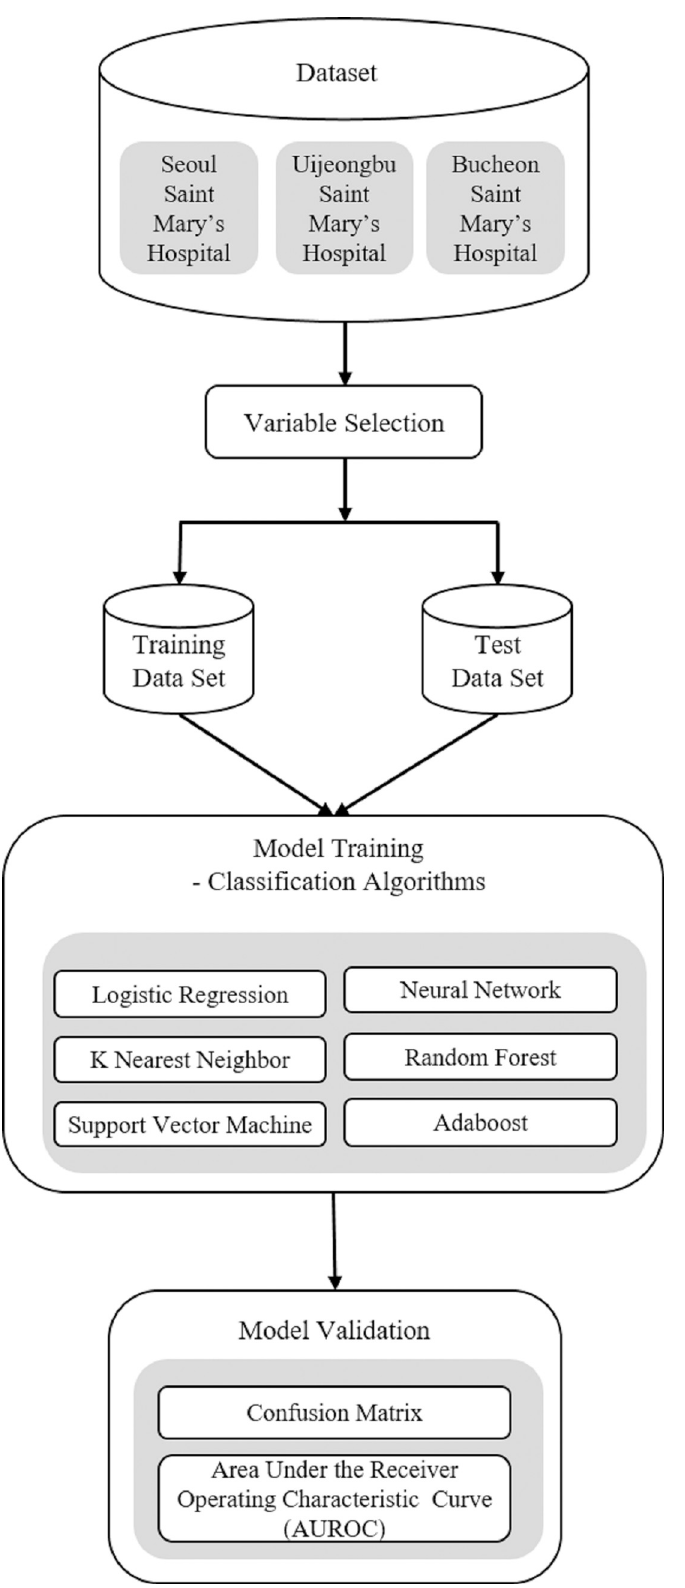
Fig 2. Block diagram of the process of the research